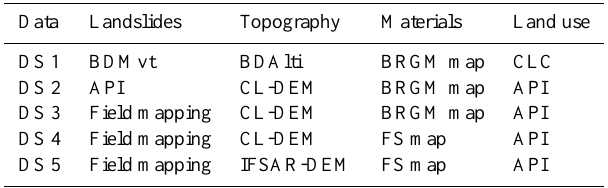
Table 2. Combination of the sets of data used for each ♦ specifically cre-